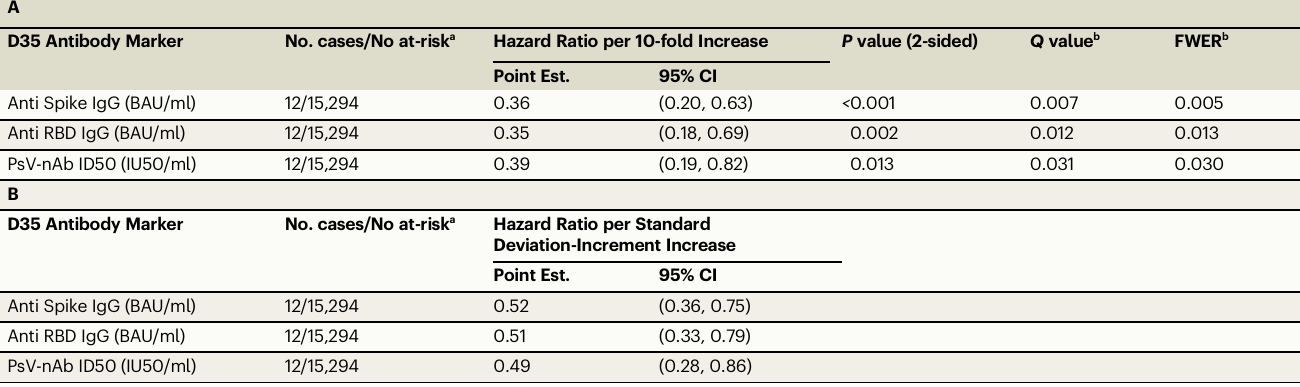
Table 2 | Hazard ratios of COVID-19 (A) per tenfold increase or (B) per standard deviation increase in each D35 marker in baseline negative per-protocol vaccine recipients (U.S. study